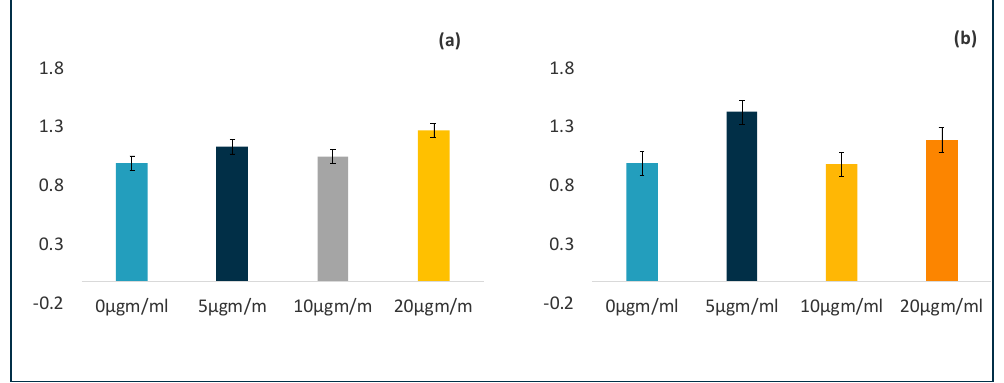
Figure 4. Effects of LPS on proliferation of PDLSCs in 3D culture. Clumps resist the effects of LPS when compared to cells grown in 2D. Graphical representation of comparison of ATP production by 3D clumps after 72 h ( a ) and 120 h ( b ) of LPS treatment. The values are of three independent experiments presented as means ± SD. * p ≤ 0.05 .